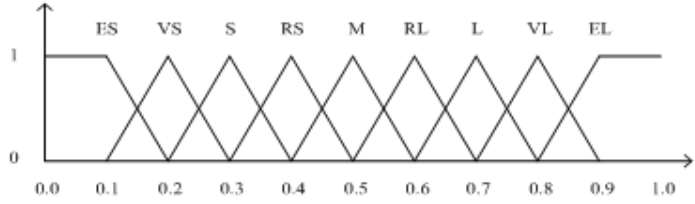
Figure 7. The membership function graphic of input and output parameter